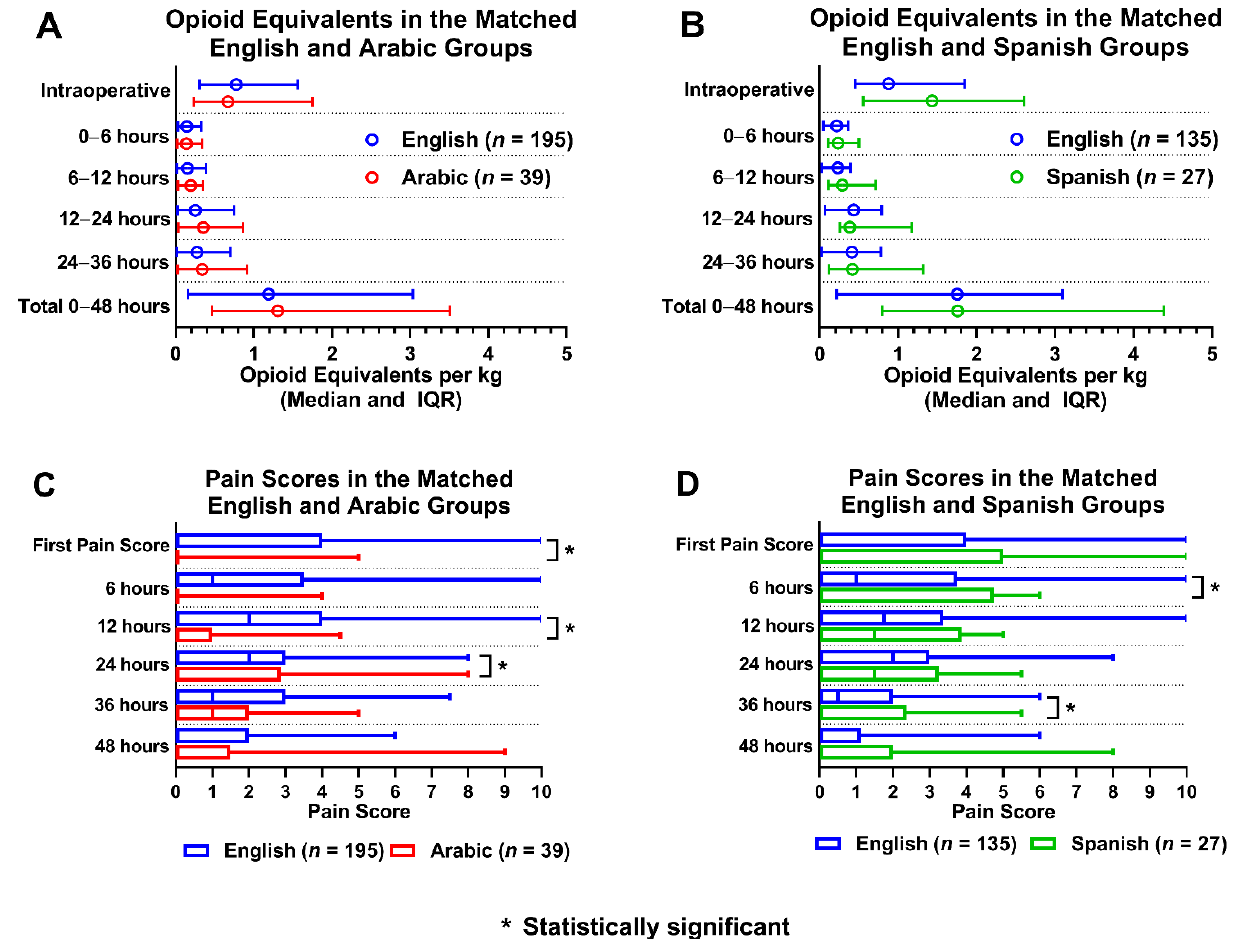
Figure 2. Opioid equivalents and pain score comparisons amongst propensity matched language groups. ( A ): Opioid equivalent per kg vs. time in matched English and Arabic groups; ( B ): Opioid equivalent per kg vs. time in matched English and Spanish groups; ( C ): Pain score vs. time in matched English and Arabic groups; ( D ): Pain score vs time in matched English and Spanish groups. Regional anesthesia was utilized as an adjunct in 68% of ES patients (369/537), 57% of AS patients (26/45), and 75% of SS patients (21/28). When the groups with regional anesthesia were compared, OEs between AS and ES patients were similar amongst the two groups. AS patients had statistically significant lower pain scores than ES patients for the first 24 h postoperatively (Figure 3). SS patients had higher OEs intraoperatively, at 12 h, and at 36 h postoperatively. SS patients had statistically significant lower pain scores only at 36 h postoperatively compared to ES patients. (Figure